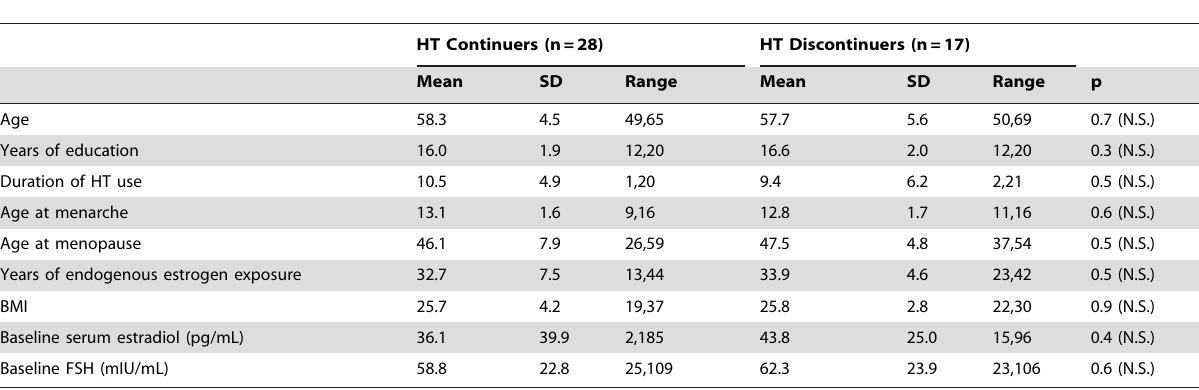
Table 1. Study Sample Demographics and Clinical Characteristics (N